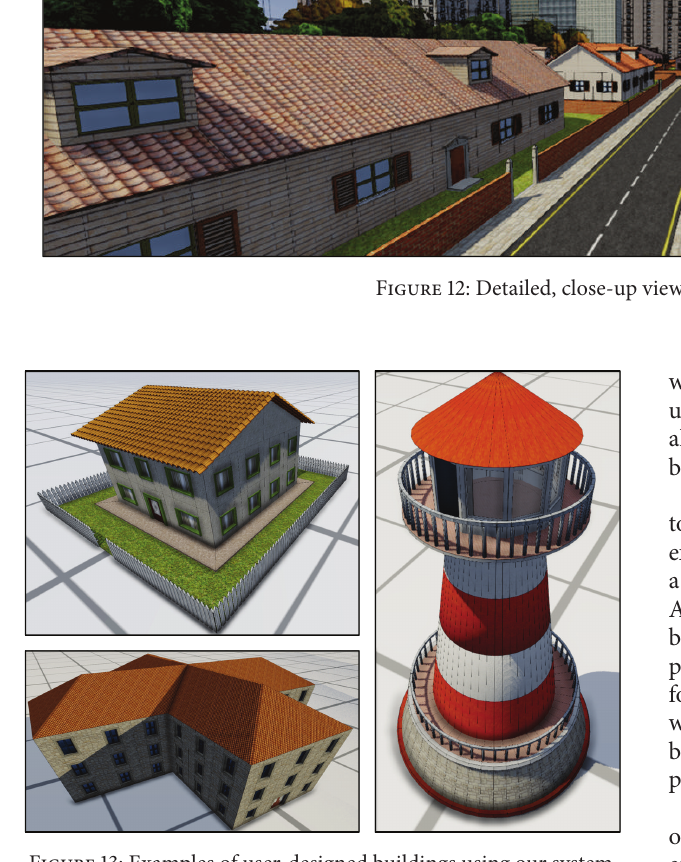
Figure 13: Examples of user-designed buildings using our